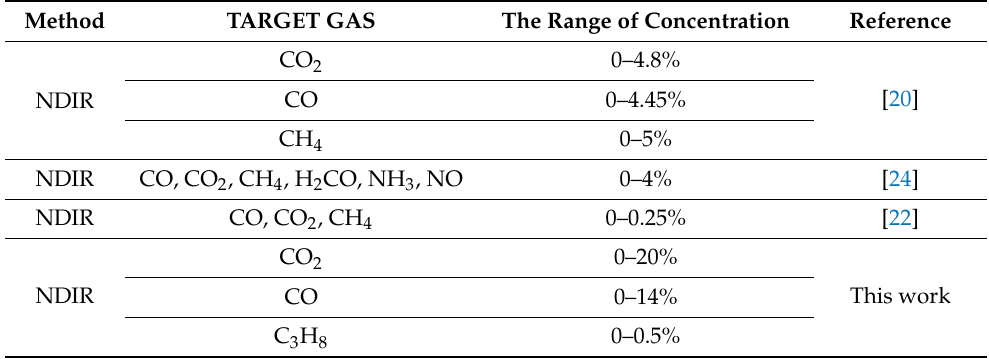
Table 2. The detection range of concentration compared with other